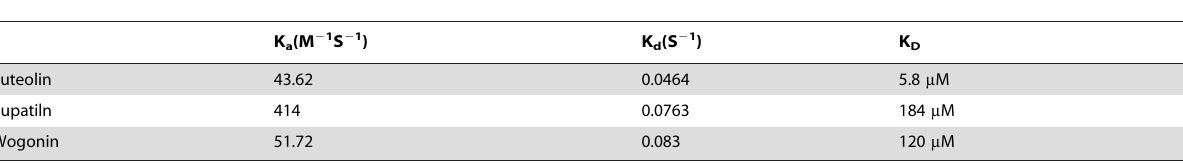
Table 1. Kinetic parameters of the binding of luteolin to